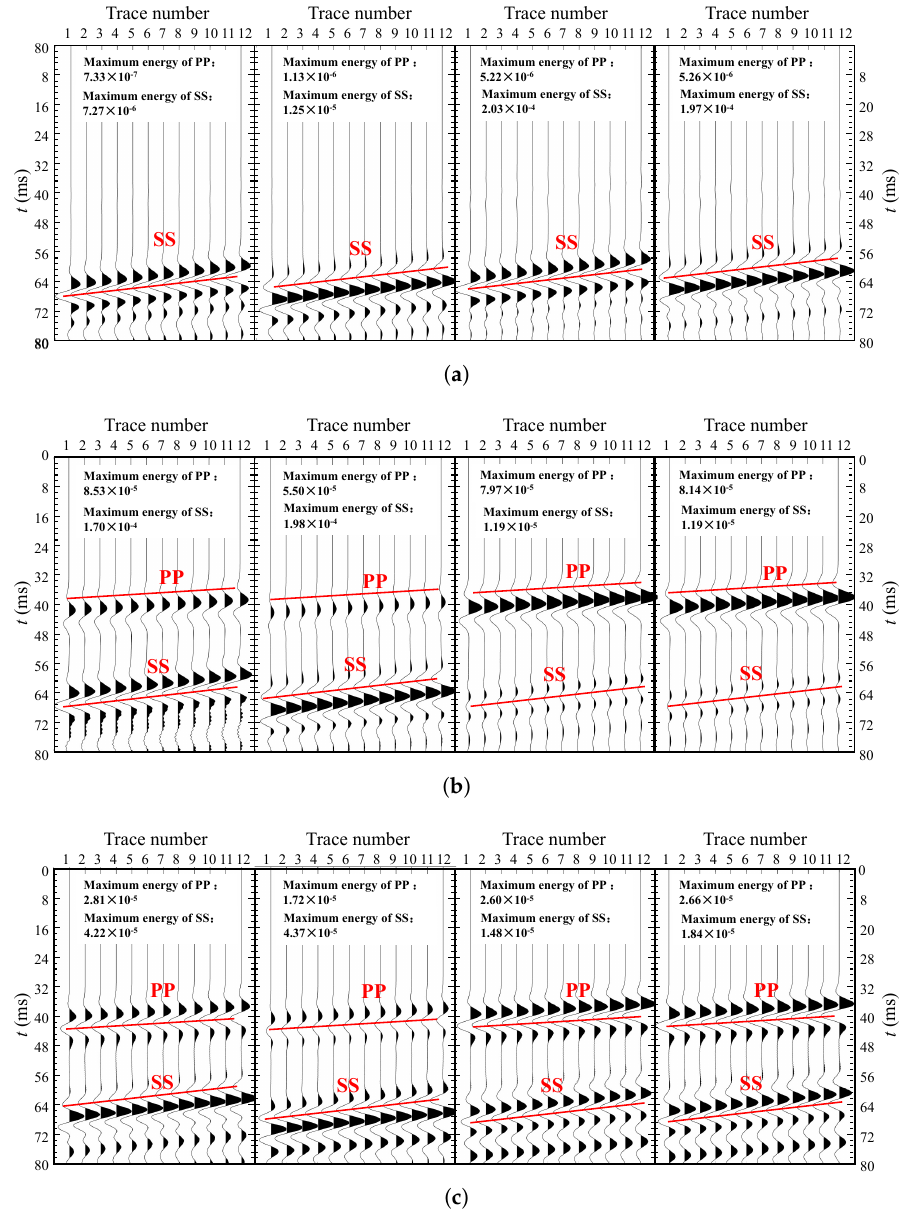
Figure 3. Seismic profile of the model with a single vertical interface of ( a ) v r component, ( b ) v θ component and ( c ) v z component. The four columns, from left to right, denote the seismic data obtained from the upper sidewall, down sidewall, left sidewall, and right wall.